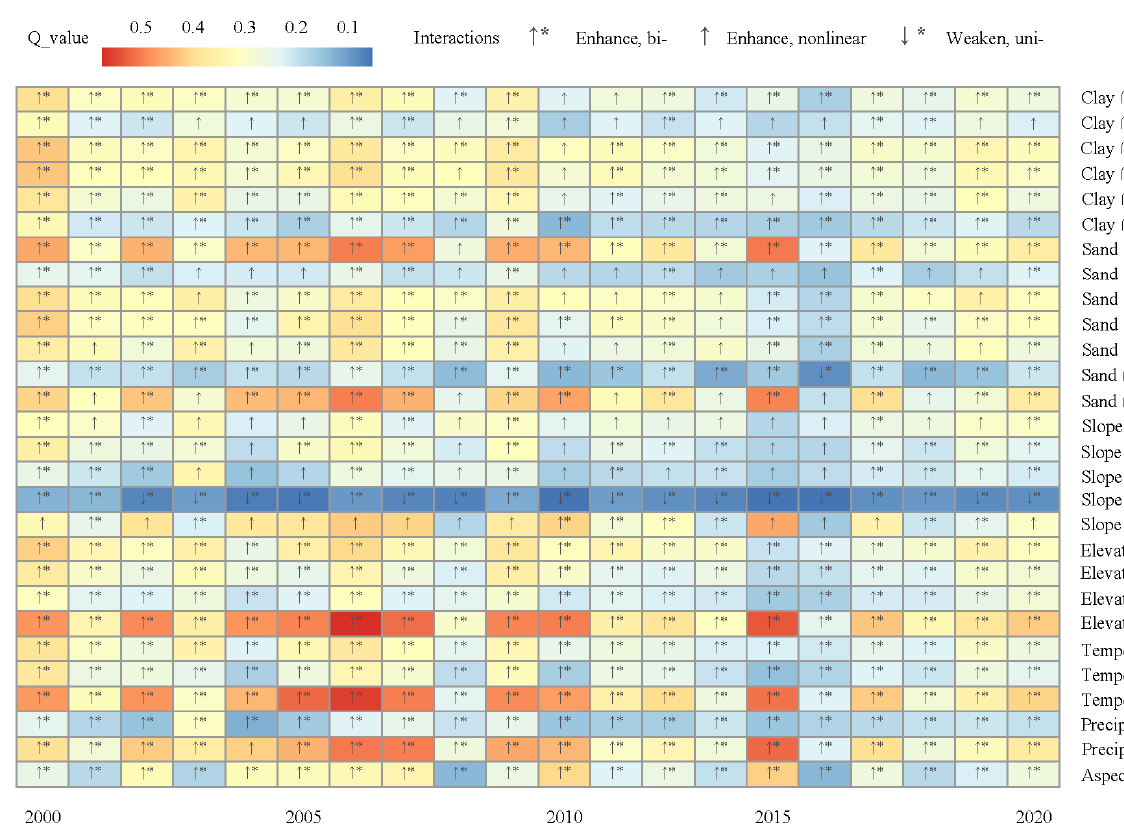
Figure 8. Q values of the FVC interaction detector from 2000 to 2020.